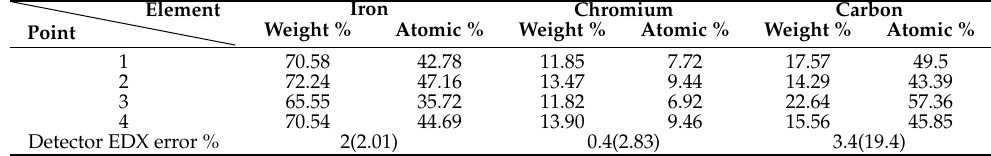
Table 3. EDX elemental analysis of microtextured design octagonal donuts shape (design type A).